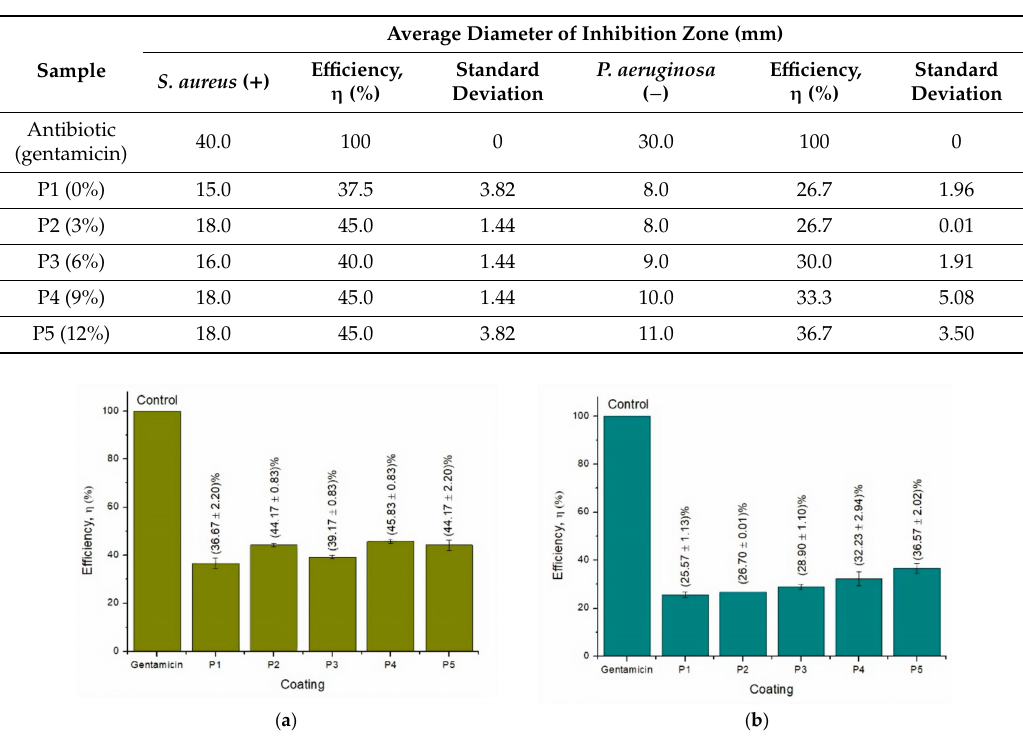
Table 6. Inhibition zone of coatings.